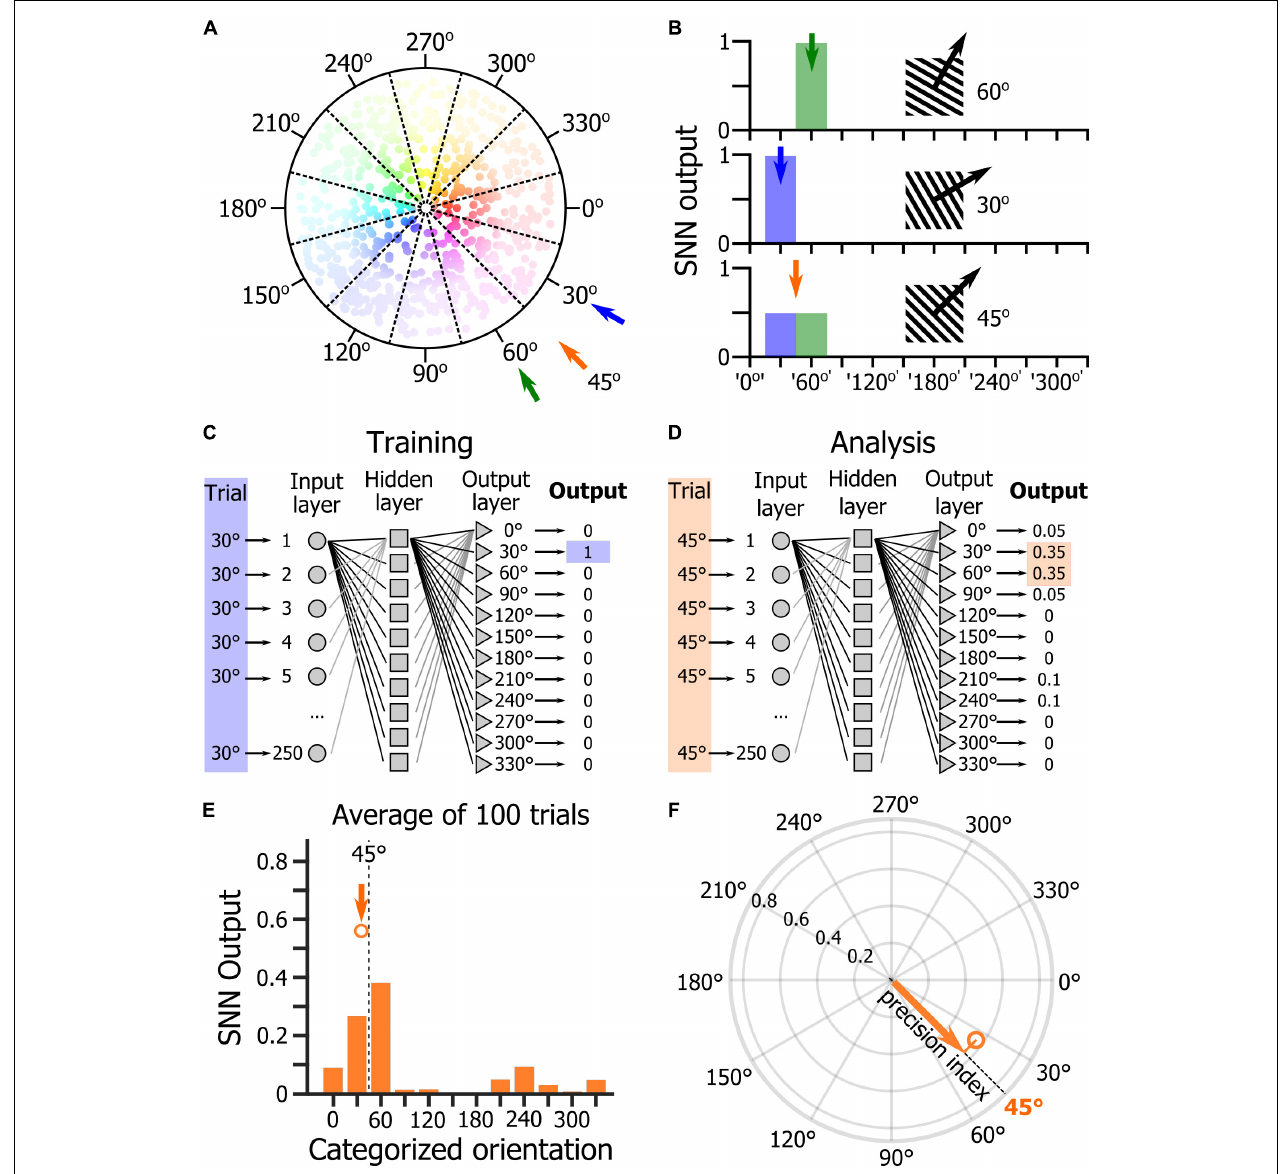
FIGURE 2 | Analysis of orientation representation in V1 using shallow neural networks. (A) Schematic representation of the distribution of the preferred orientations of V1 neurons. Each dot represents a neuron. The hue represents the preferred orientation of the neuron, and the hue intensity represents the amplitude of the neuronal response to the presentation of its preferred orientation. (B) Schematic representation of the response of a SNN trained to discriminate the V1 population response to the presentation of a 30 ◦ drifting grating (top panel) and to the presentation of a 60 ◦ drifting grating (middle panel). When the SNN is provided with the response of its input cortical neuron population for the presentation of a 45 ◦ drifting grating (bottom panel), its output should indicate an equal probability that the stimulus belongs to the ‘30 ◦ ’ and ‘60 ◦ ’ categories. (C) Schematic representation of the SNN training. (D) Schematic representation of the SNN testing with a 45 ◦ stimulus that does not belong to the training categories. (E) Average output across 100 trials of the presentation of a 45 ◦ drifting grating of a randomly selected trained SNN. The dot indicates the orientation and length of the circular mean vector computed from the mean distribution of the SNN output. (F) Precision index defined as the length of the vector resulting from the projection of the circular mean vector onto the axis of the visual stimulus